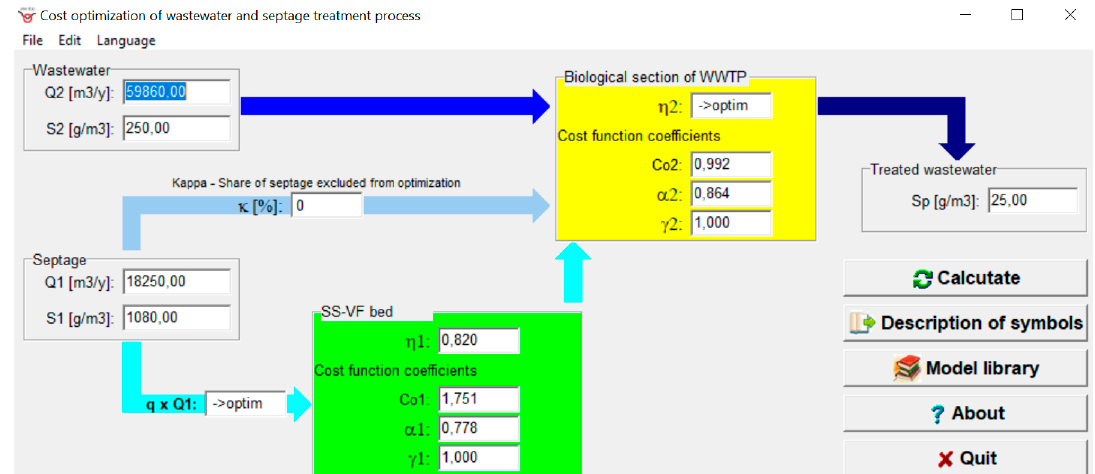
Figure 7. Computer program “Cost optimization of wastewater and septage treatment process”, example 2—summary of the input data .